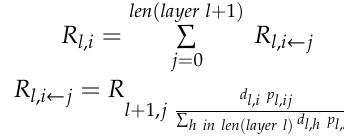
Figure 4. Image of tanh ( x ) and tanh ( x )’ .